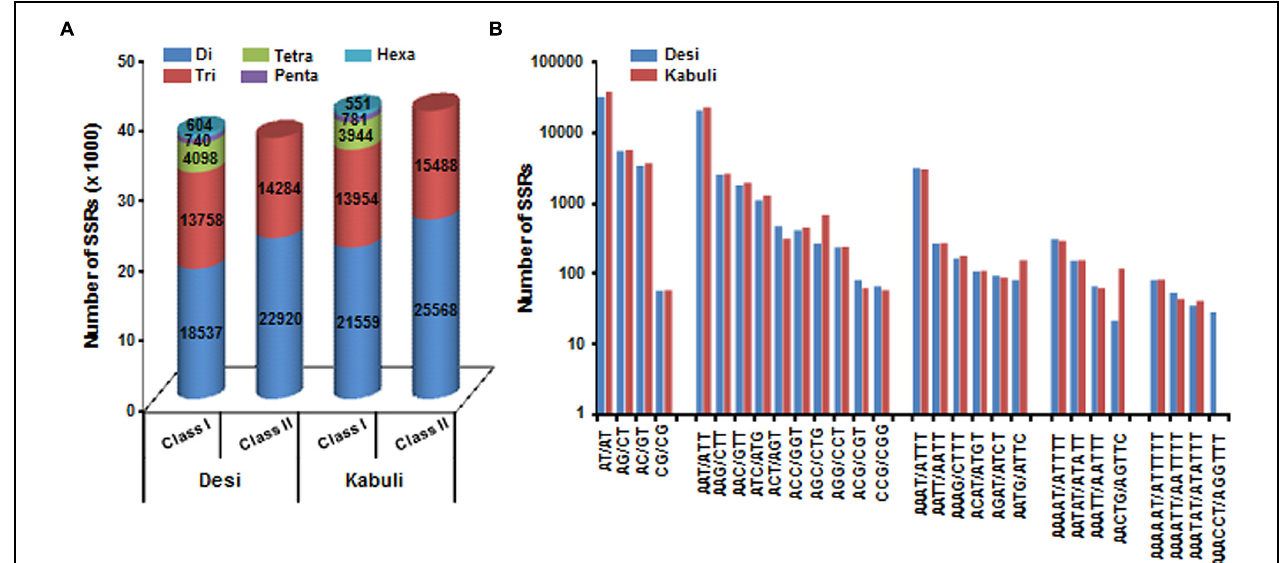
FIGURE 1 | Classification and frequency of simple sequence repeats (SSRs) identified in desi and kabuli chickpea genomes. (A) The bar graph displays the number of SSRs of different types in long hypervariable class I ( ≥ 20 nt) and potentially variable class II (12–20 nt). (B) Frequency of major SSR motifs of different classes identified in desi and kabuli genomes.